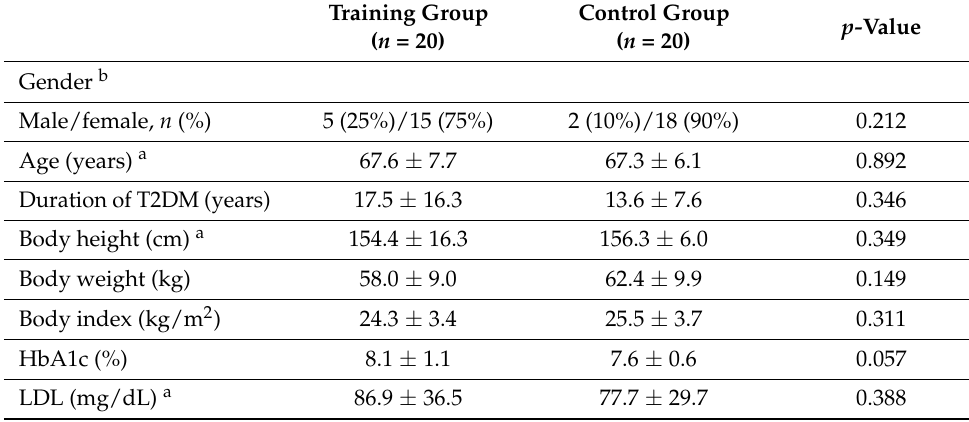
Table 1. Baseline characteristics of